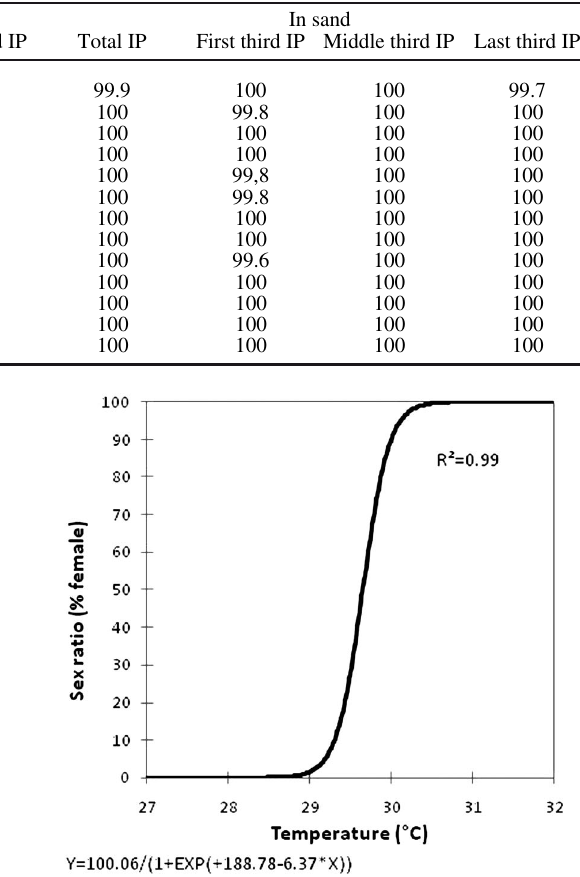
Fig . 2. – Percentage of females as a function of temperature (De- rived from Mrosovsky et al. (2002) and adapted to the